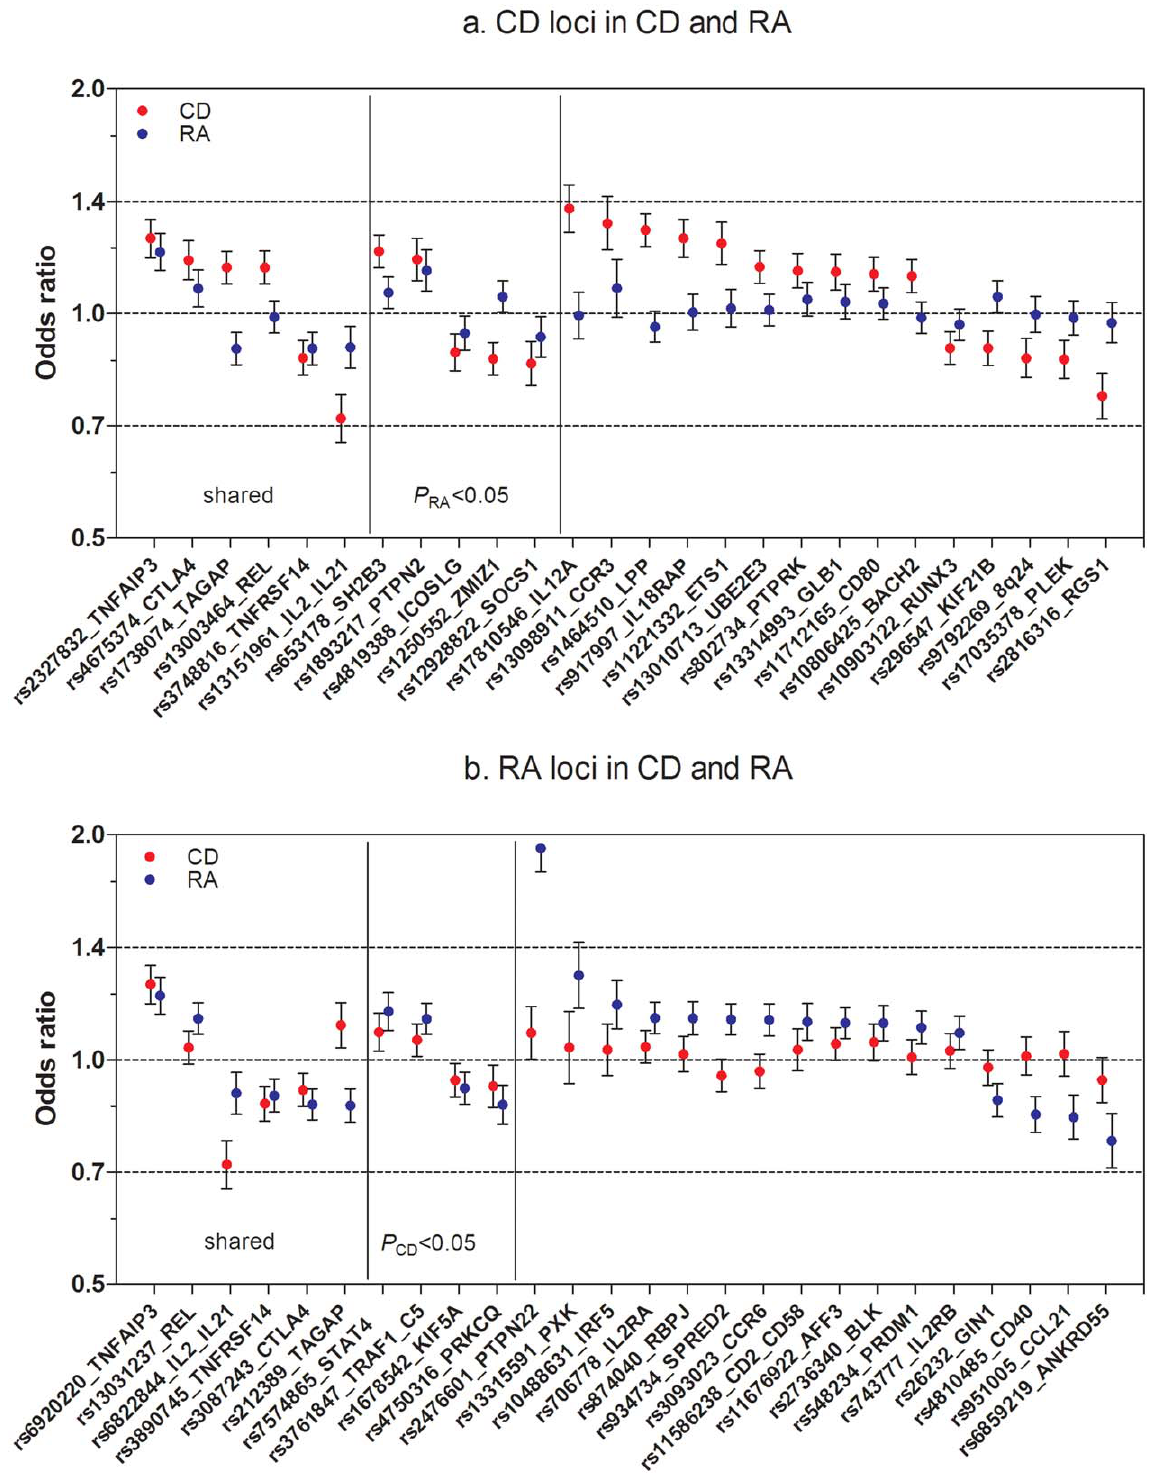
Figure 1. Established CD and RA SNPs and their association across diseases. (A) Known CD SNPs in RA. The figure represents OR and CI for the established CD SNPs (p , 5 6 10 2 8 , one SNP per locus) in RA meta-analysis (5,539 auto-anbitody positive cases and 17,231 controls). (B) Known RA SNPs in CD. The figure represents OR and CI for the established RA SNPs (p , 5 6 10 2 8 , one SNP per locus) in CD meta-analysis (4,533 cases and 10,750 controls). For the six shared loci established in both diseases, figure 1A includes the top CD SNP and figure 1B the top RA SNP. From six shared loci, three ( TNFRSF14 , IL2/IL21 and TNFAIP3 ) are associated with same SNP or a good proxy (r 2 . 0.9) in both diseases; in other three loci – CTLA4 , REL and TAGAP – the most associated SNPs in CD and RA are not in strong LD with each other (r 2 , 0.3), which is reflected in moderate association ( CTLA4 ) or no association ( REL ) of these SNPs in the second disease. The TAGAP SNPs show association to opposite alleles in CD and RA.